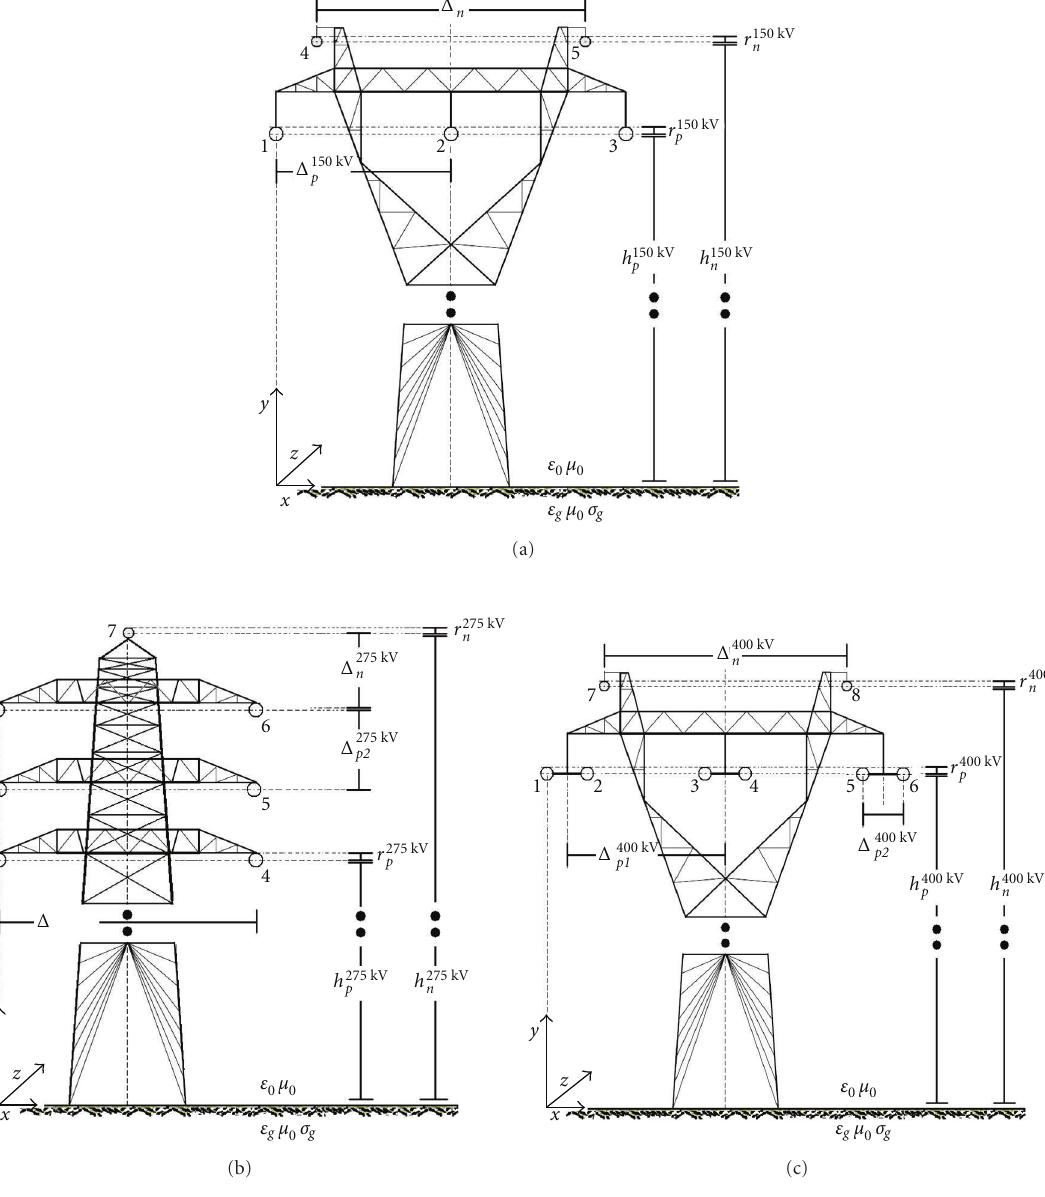
Figure 1: Typical overhead HV multiconductor structures [13, 24, 49–51]. (a) 150 kV single-circuit. (b) 275kV double-circuit. (c) 400 kV